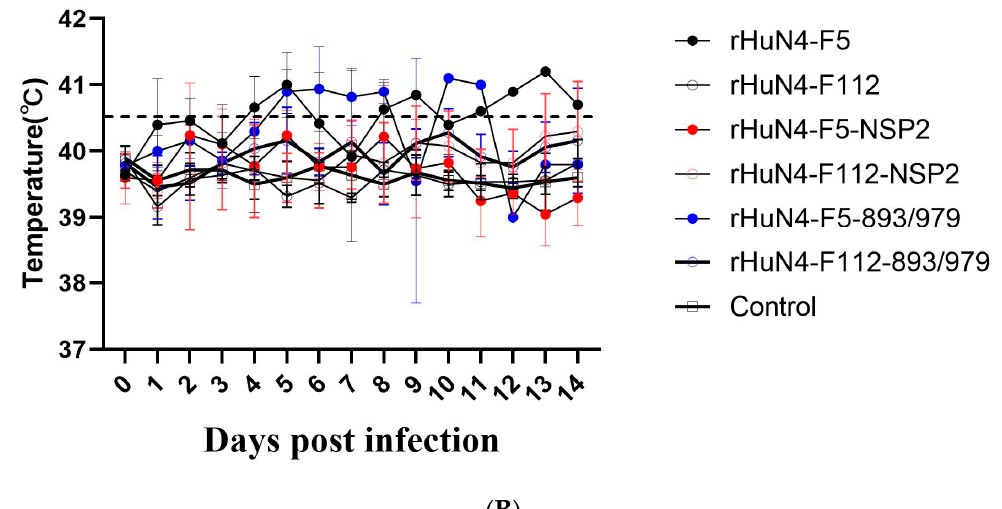
Figure 4. Survival rate and rectal temperature after infection. ( A ): Survival rate of each group. ( B ): Mean rectal temperature of each group after infection. Mean rectal temperatures were presented as means ± standard deviations (error bars).